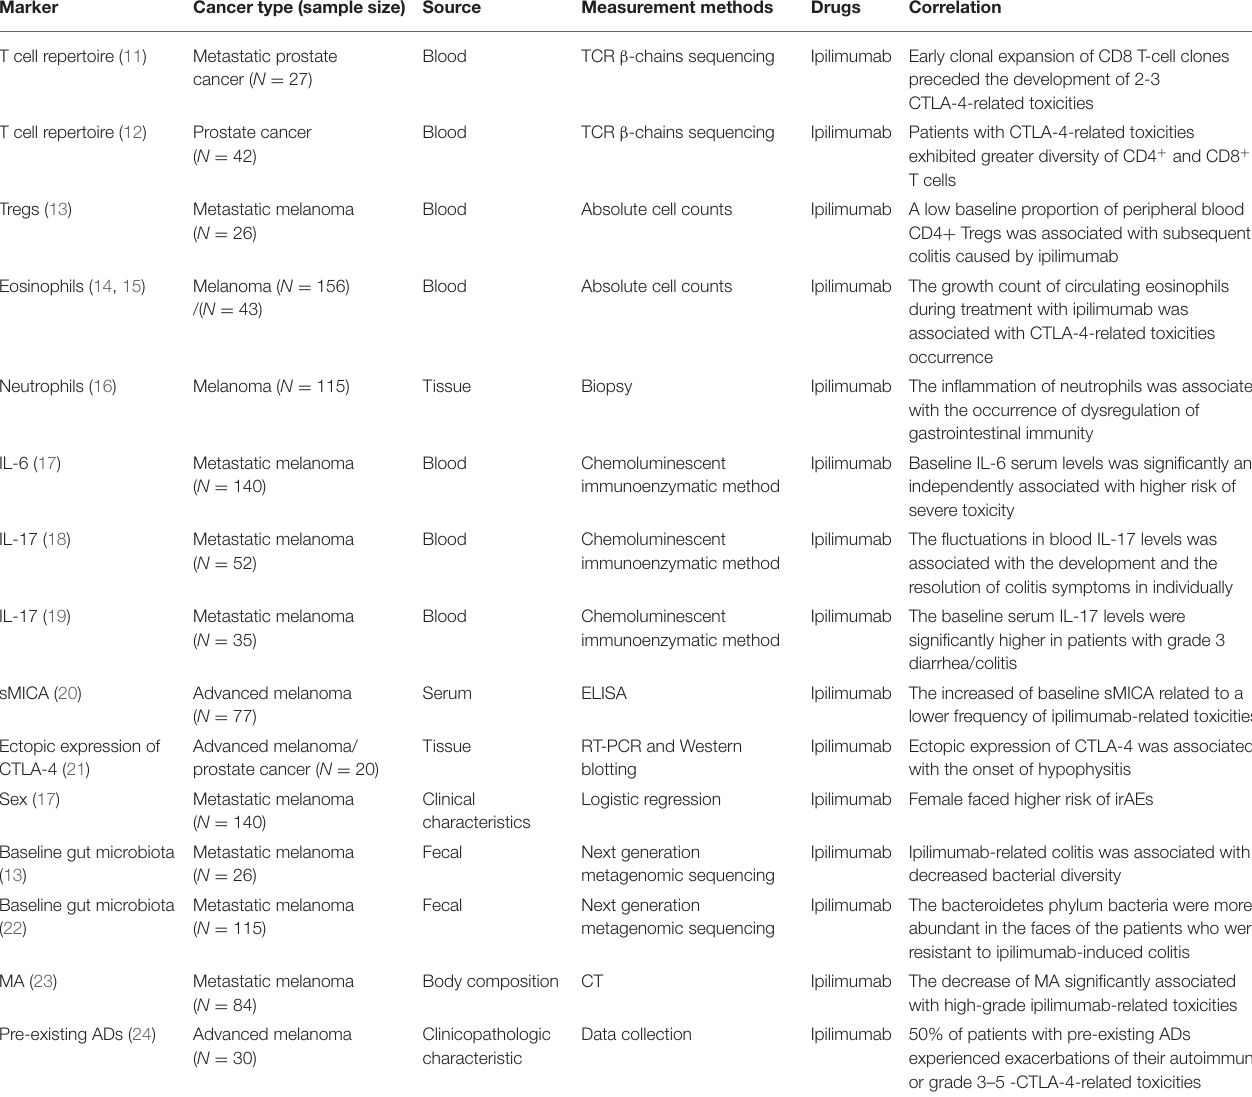
TABLE 1 | Predictive biomarkers for CTLA-4 inhibitor-related toxicities.